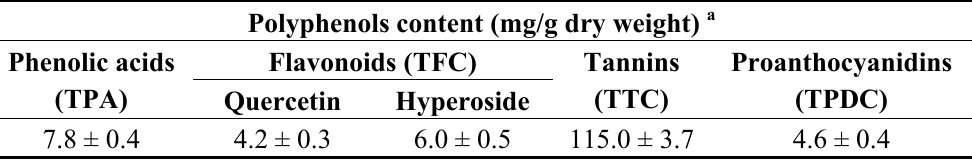
Table 2. Content of polyphenolic compounds in D.